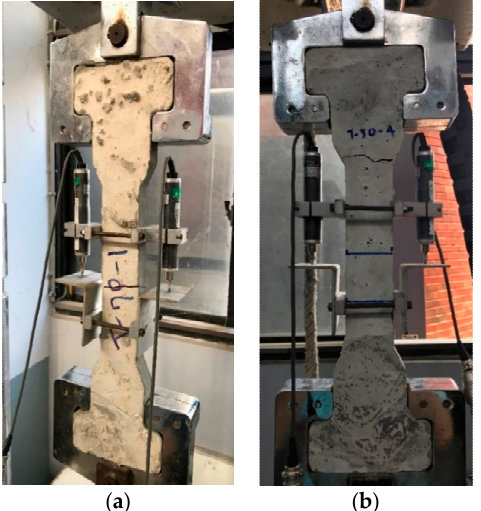
Figure 14. Failure mode of direct tension test. ( a ) Typical failure and ( b ) unexpected failure.